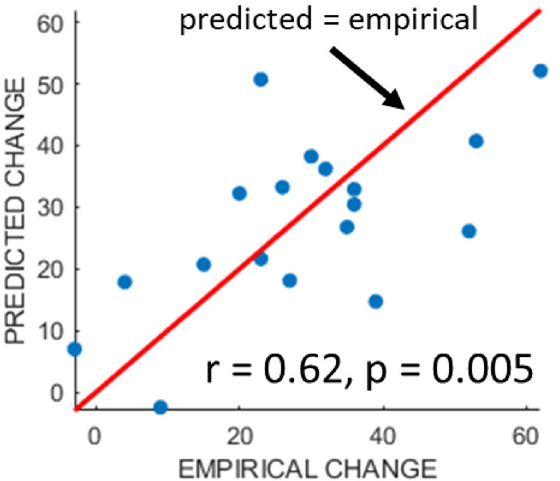
Figure 1. Predicted responses versus empirical responses, for the best model identified in Table 1 (lesion load variables + hours of therapy undertaken).